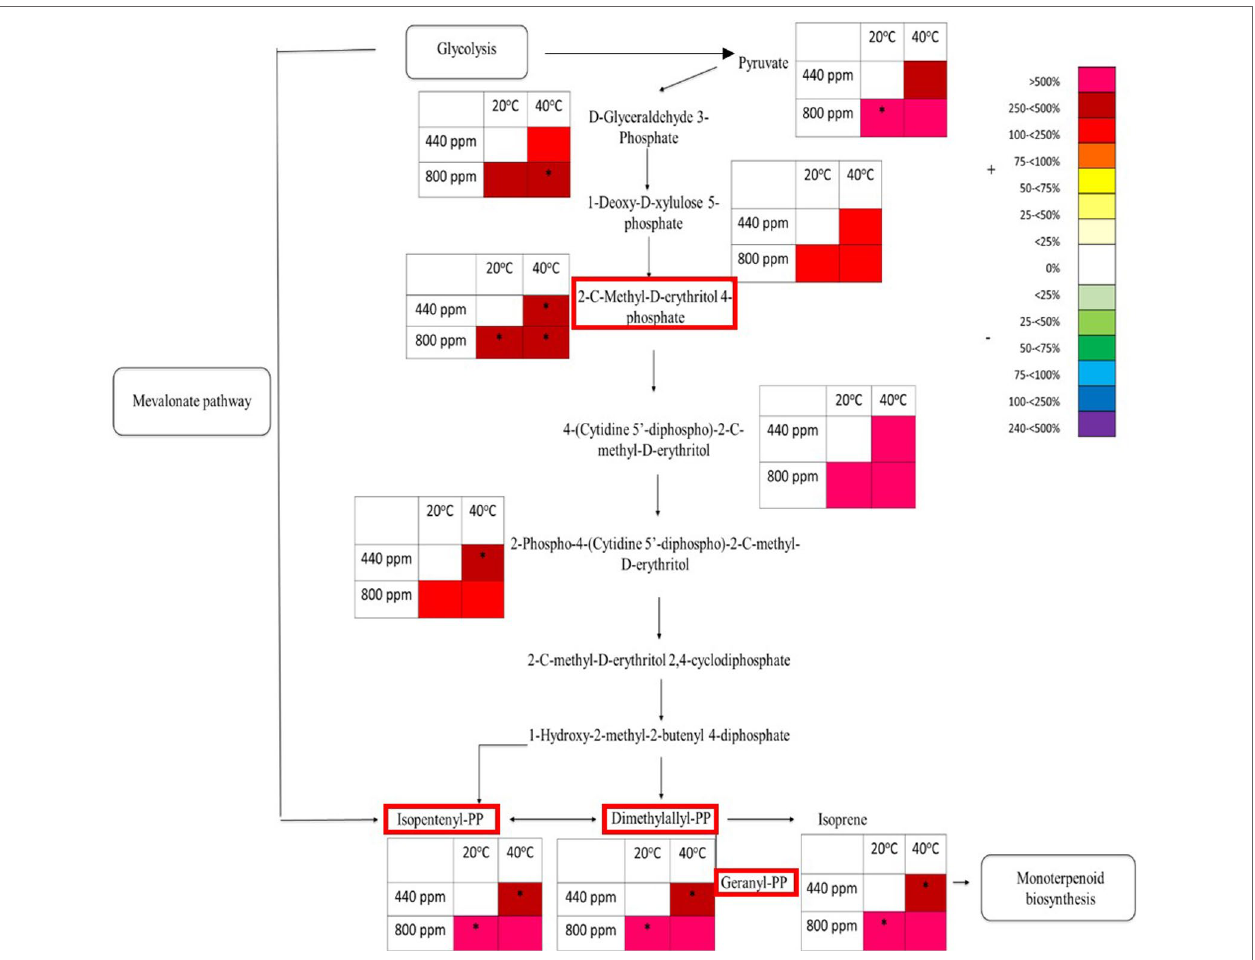
FIgURE 6 | Schematic pathway diagram of glycolytic, mevalonate, non-mevalonate and monoterpenoid biosynthesis. The tables show abundance of the metabolites calculated from the % total ion count for data from MALDI-ToF analysis (polar phase analysed in negative ionisation mode). * indicates statistically significant changes in % differences of the total ion count relative to treatment. The % bar scale shows increase or decrease in abundance of %TIC. Red boxes around specific secondary metabolites indicate identification using tandem MS against an analytical standard. Each point in the table for each metabolite represents a pooled replicate per plant across the four